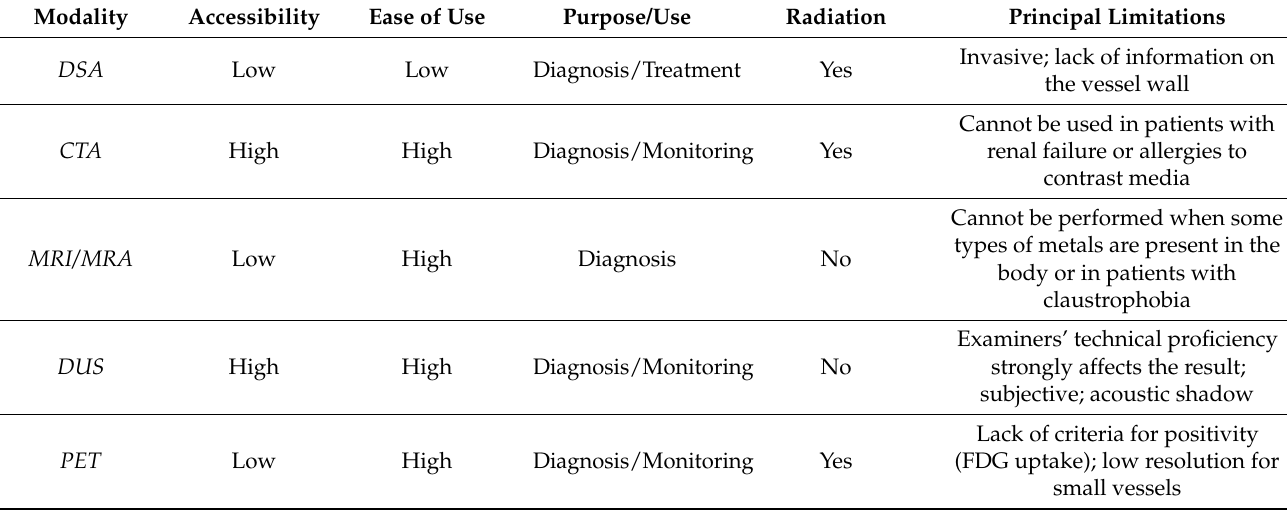
Table 1. Comparative analysis of conventional imaging techniques in diagnosis and monitoring of